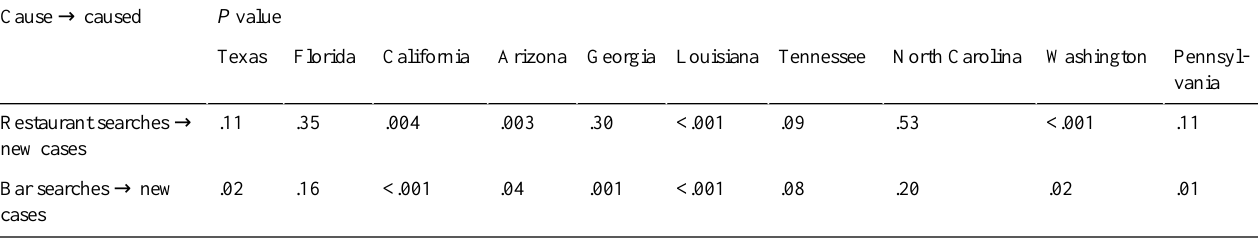
Table 1. P values of the Granger causality tests on daily new cases of COVID-19 for the 10 US states and territories with the most daily new cases from April 9 to July 7, 2020.